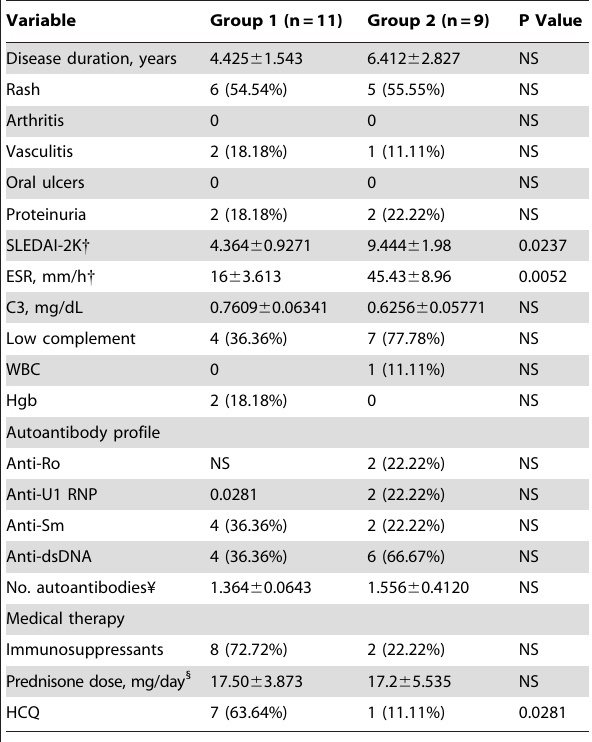
Table 2. Comparison of SLE patients in the two clusters.